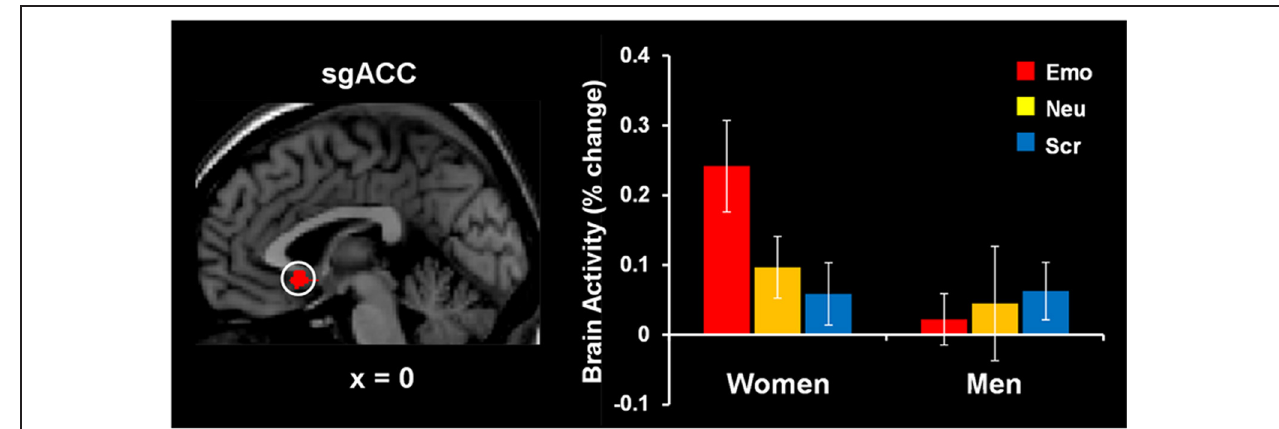
FIGURE 8 | Increased subgenual anterior cingulate cortex (sgACC) activity to emotional distraction, in women. The area indicated by the white circle (BA 25), showing a difference in activation in response to angry faces in women versus men, was masked with a map identifying a main effect of emotion relative to baseline in women. The bar graph illustrates the fMRI signal, as extracted from the region of interest corresponding to the